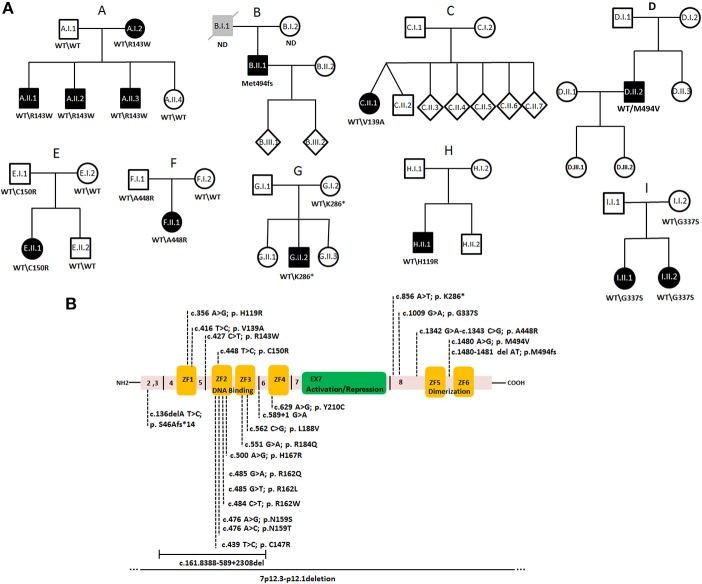
Autosomal dominant inheritance of IKAROS heterozygous mutations in CVID families of a cohort of 650 individuals. (A) Pedigrees of families A–I. Circles, female; squares, male; black filled symbols, affected individual; gray filled symbols; individual with hypogammaglobulinemia without CVID-related symptoms, open symbol; unaffected; slash, diseased. (B) Schematic presentation of the structure of human IKAROS. The N-terminal DNA binding domain composed of four zinc finger motifs (yellow boxes, ZF1–ZF4), the central activation/repression domain (green) and the C-terminal dimerization domain (ZF5–ZF6). Exon borders and amino acid positions are indicated. Dotted lines in the upper part indicate heterozygous variants identified in this study. Lower parts shows previously published IKZF1 mutations (16, 34–38).